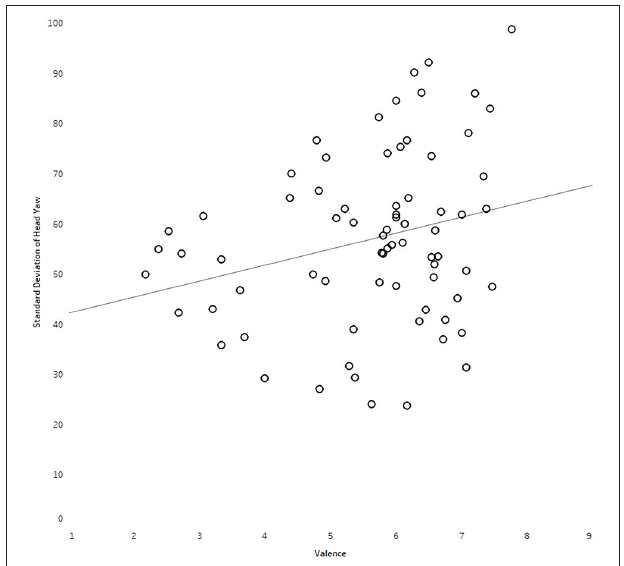
FIGURE 7 | Plot illustrating the relationship between head pitch and arousal